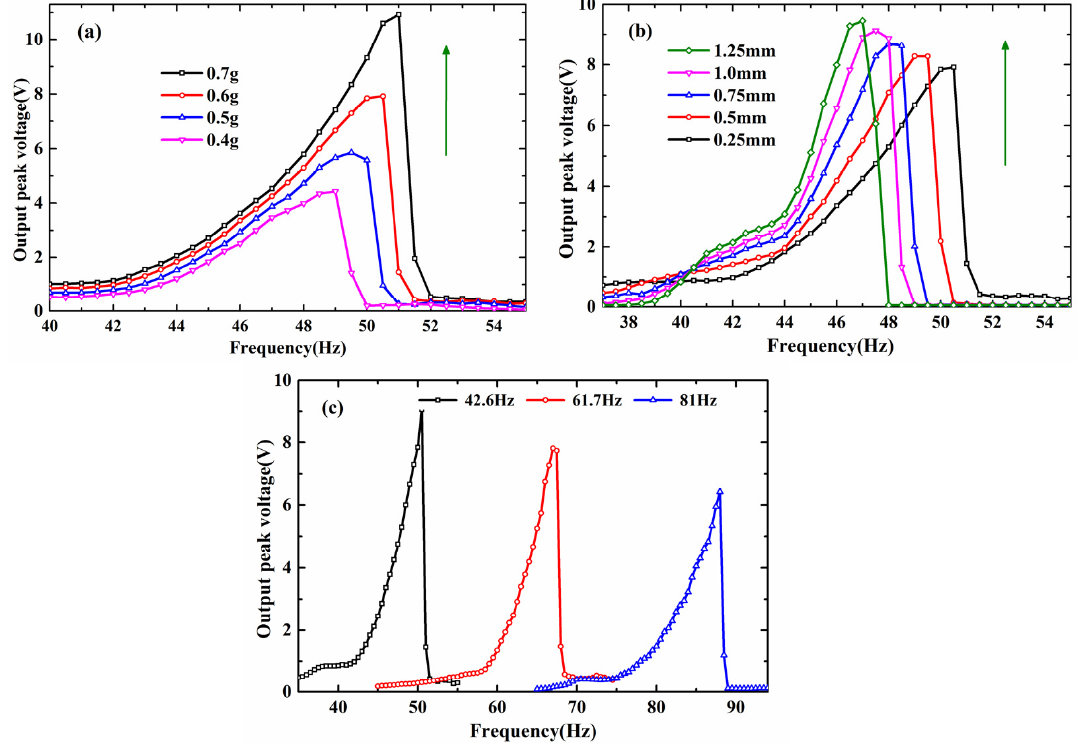
Figure 8. Parameters effects on the frequency response of the proposed wideband VEH system: ( a ) demonstrates the effects due to changing acceleration; ( b ) demonstrates the effects due to changing rope margin; ( c ) demonstrates the effects due to changing stiffness of the driving beam